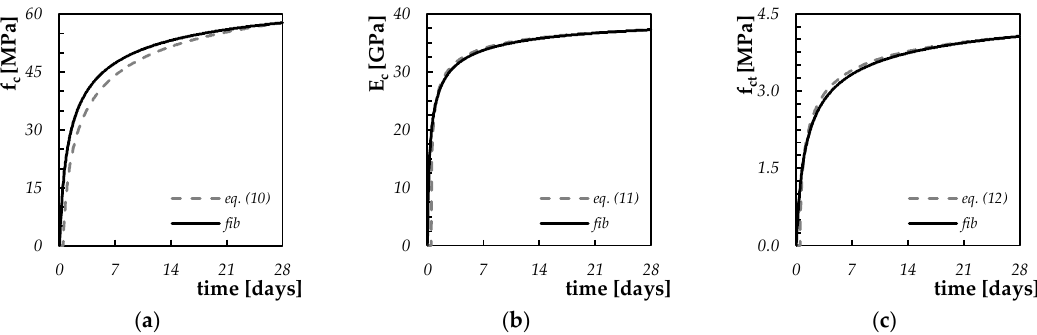
Figure 3. Comparison between the proposed equations and the fib Model Code 2010 formulas for the definition of the time evolution of the mechanical performances of C50 / 60: ( a ) compressive strength, ( b ) elastic modulus and ( c ) tensile strength.